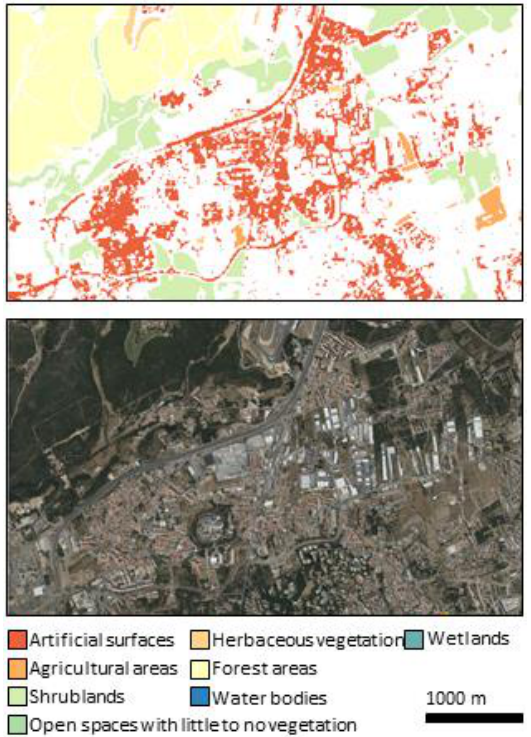
Figure 2. Above: Detail of the OSM derived training data for the LXMA study area, where white areas represent areas with no OSM training coming from OSM2LULC. Below: Bing maps as basemap.